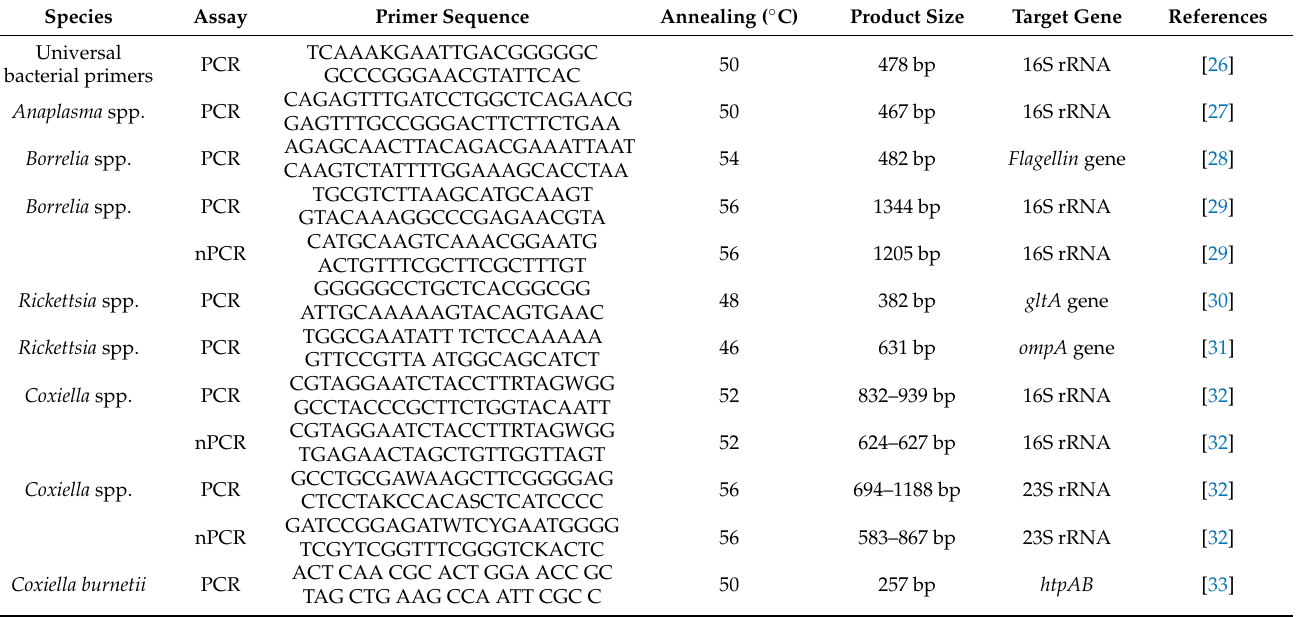
Table 1. List of primer sequences used for the detection of bacterial